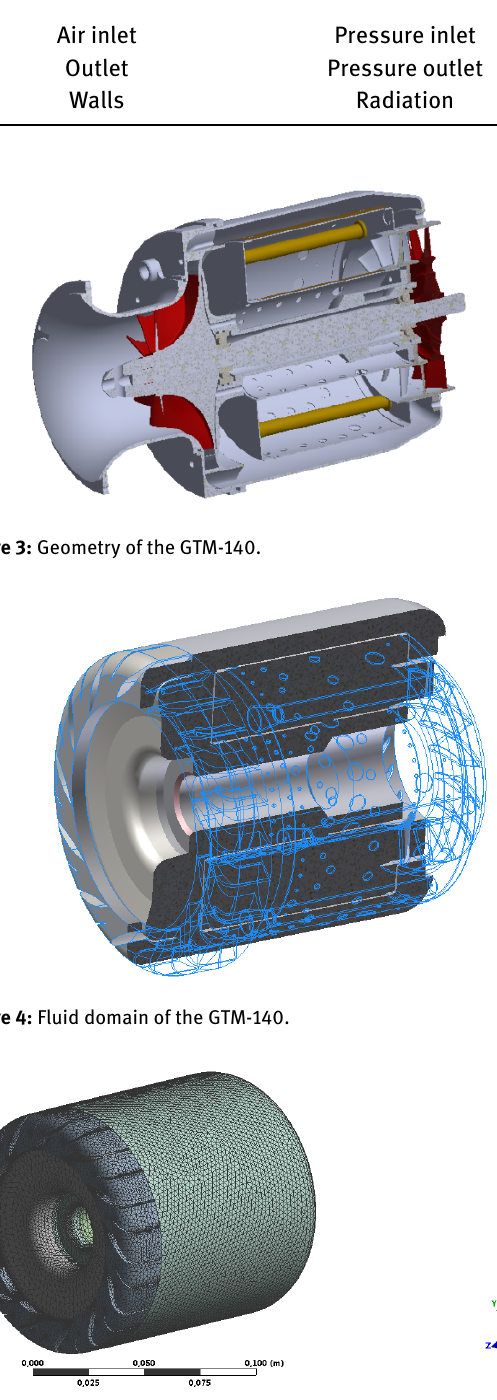
Figure 5: The discretized domain.